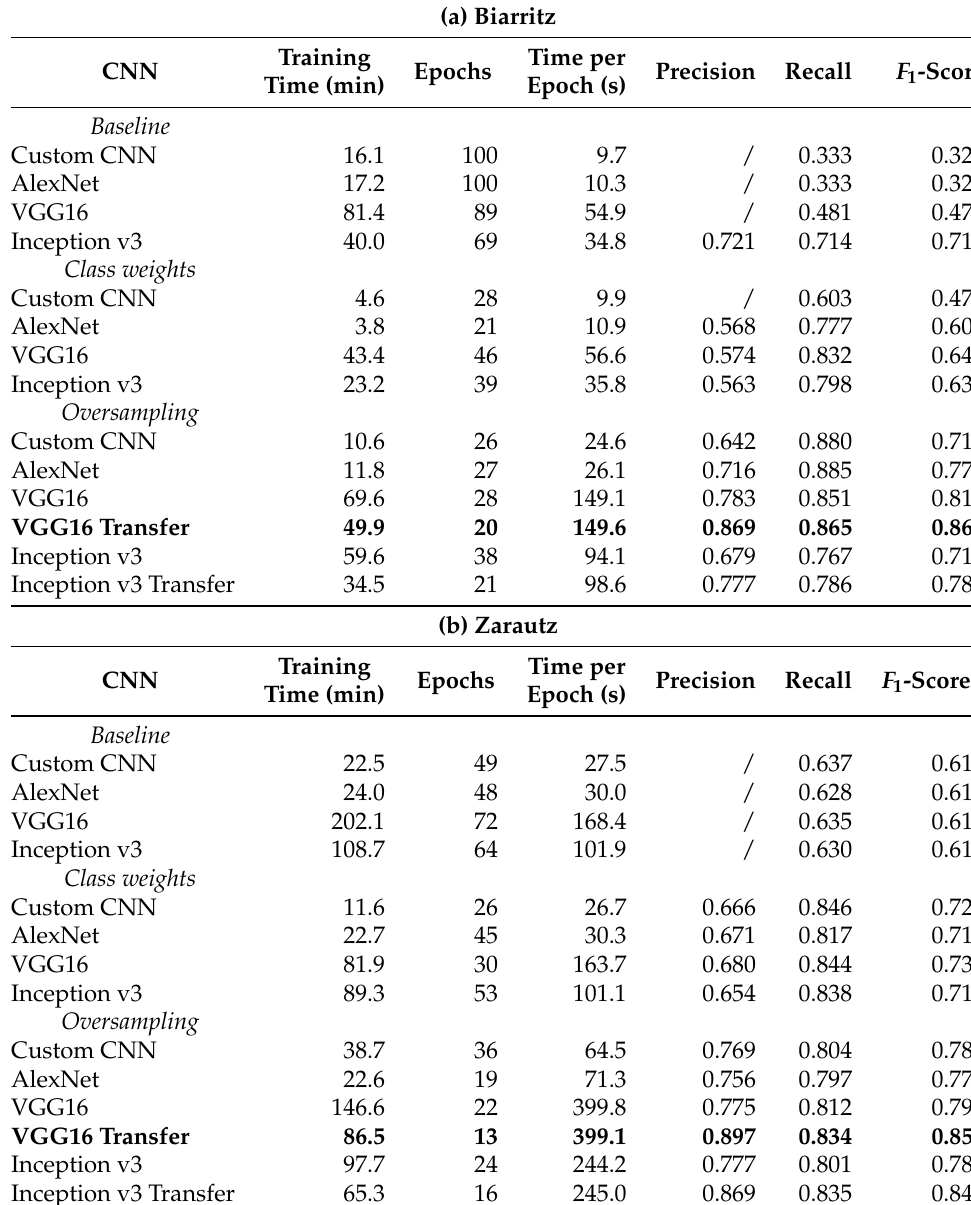
Table 1. CNN performances for both sites. Best models are in bold font.